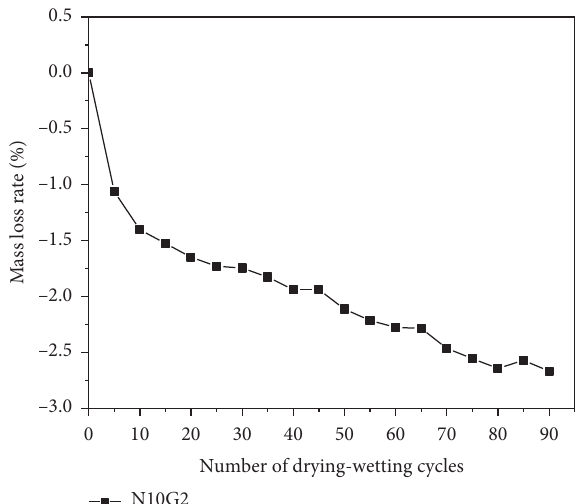
Figure 7: Variation of the mass loss rate of concrete with different drying-wetting cycle